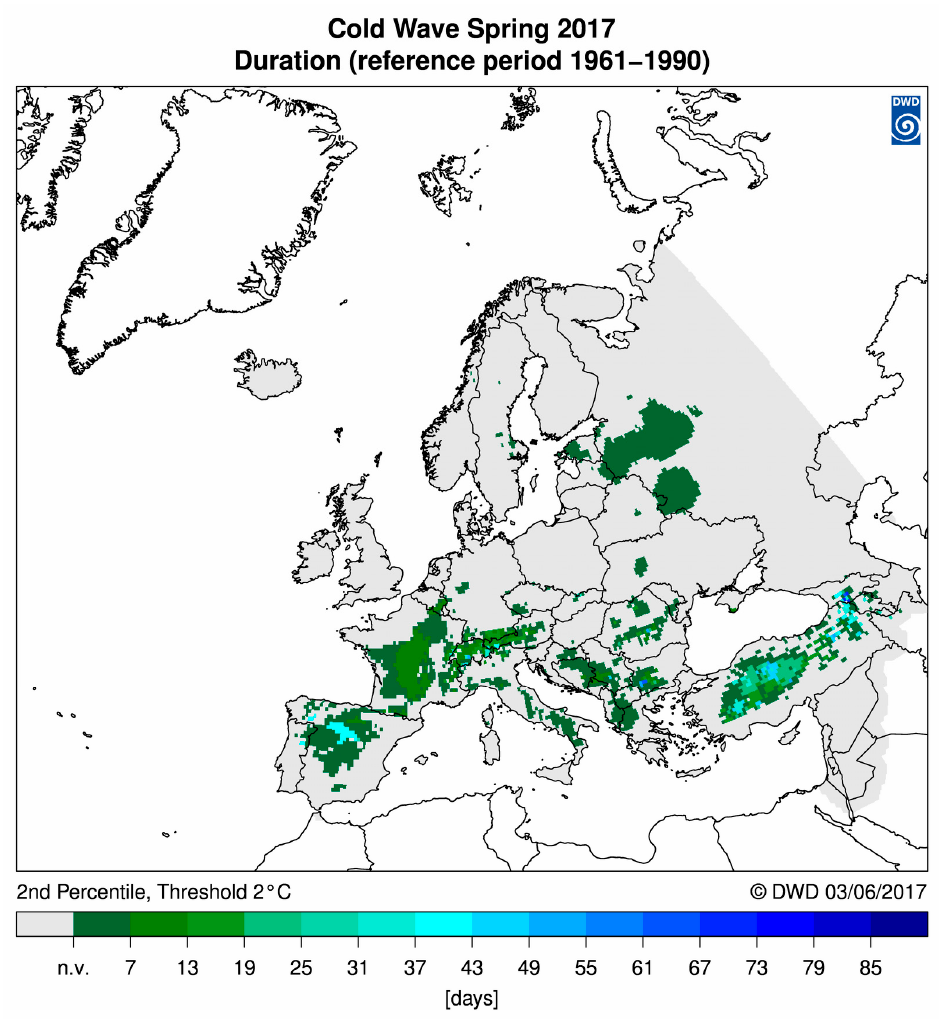
Figure 3. Duration of the cold wave in spring 2017 according to the German weather service, DWD [22].